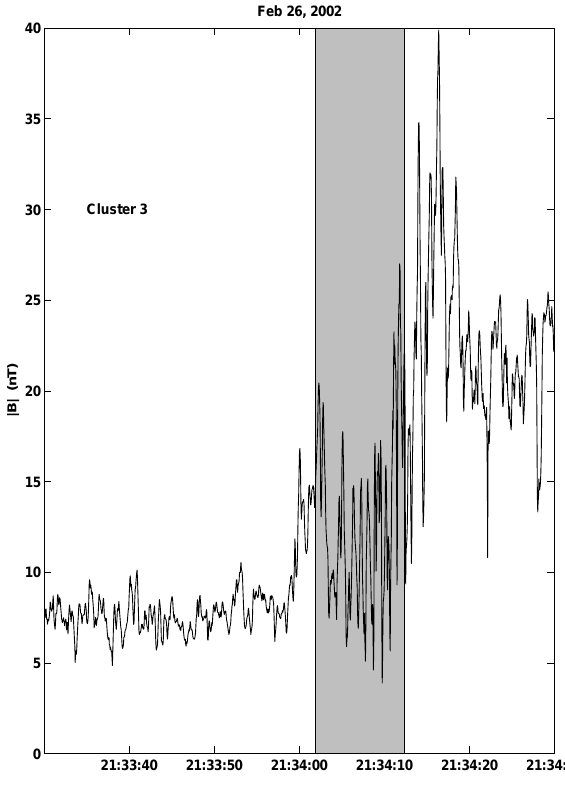
Fig. 2. The magnetic profile of the bow shock crossing observed by Cluster 3 on 26 February 2002 just after 2134UT. The period for which EFW internal burst mode data is available is indicated by the shaded